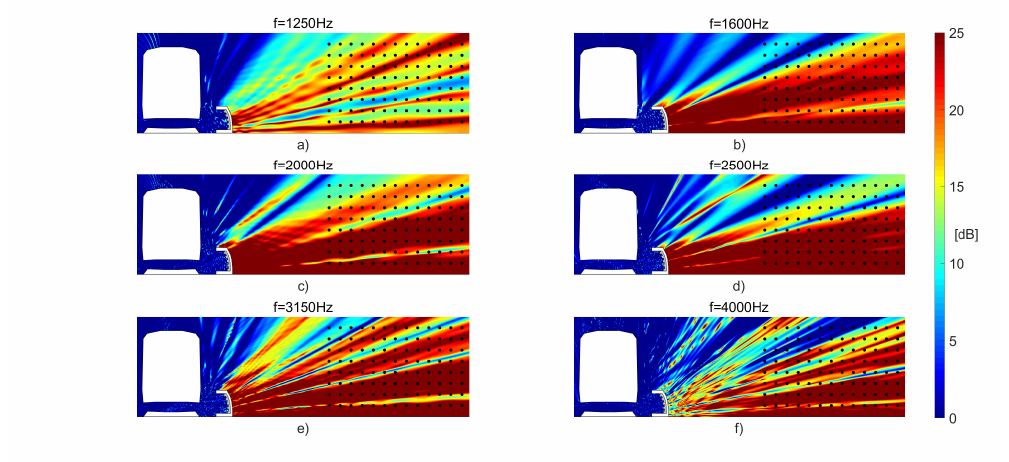
Figure 21. Insertion loss maps for the curved noise barrier with absorptive layer for frequencies 1250 Hz, 1600 Hz, 2000 Hz, 2500 Hz, 3150 Hz and 4000 Hz ( a – f ), with the presence of the receivers (black dots) used to calculate mean IL (Figure